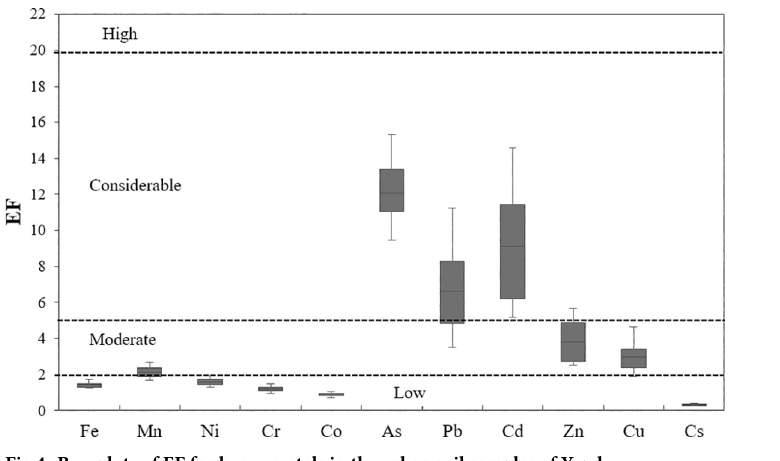
Fig 4. Box-plots of EF for heavy metals in the urban soil samples of